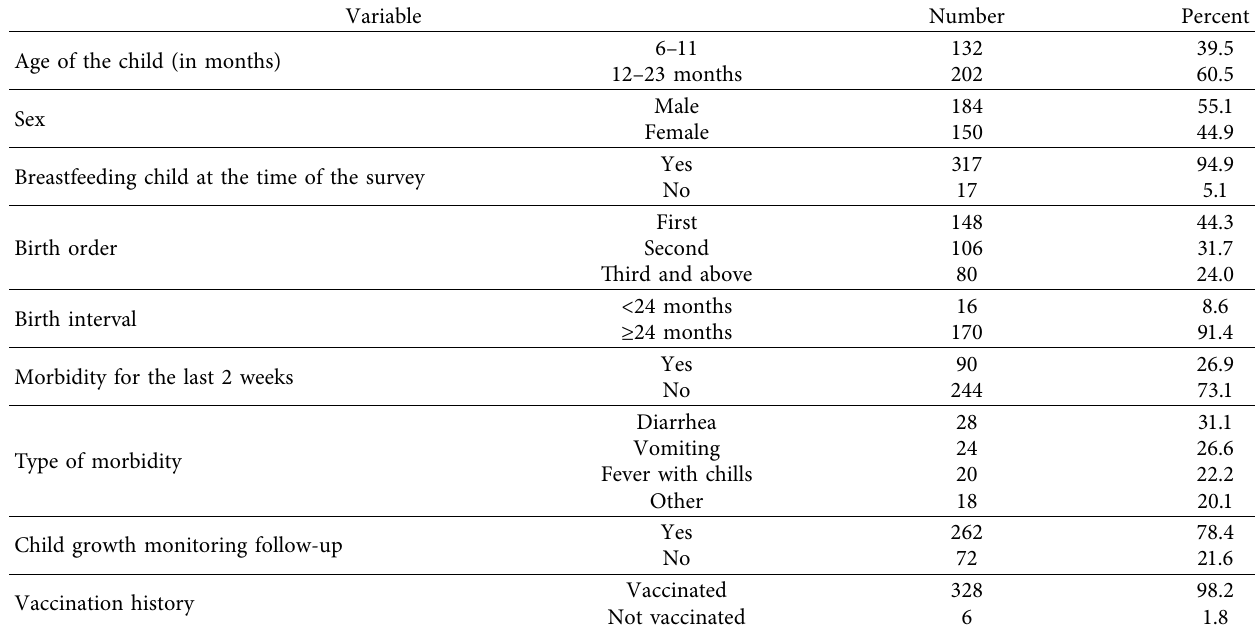
Table 2: Health-related characteristics of children ( N � 334).